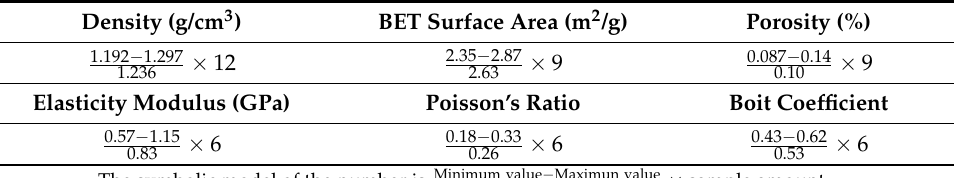
Table 2. Characterization data of coal blocks.